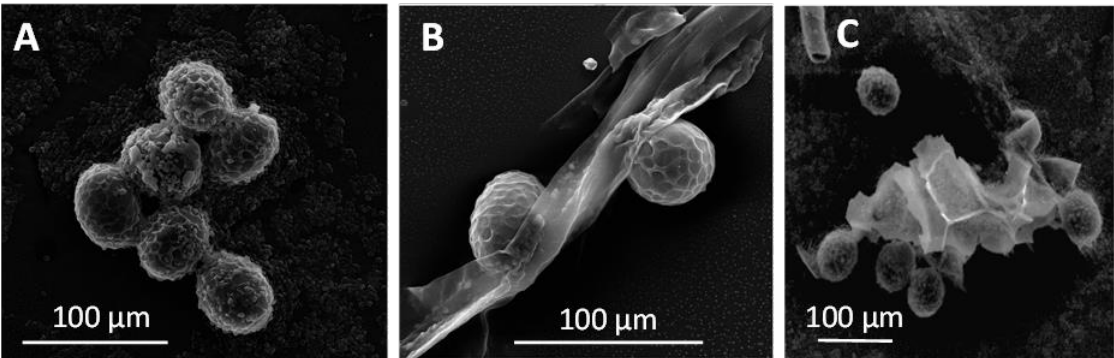
Figure 6. Scanning electron microscope images of A. suum eggs in tap and wastewater: eggs in clean tap water ( A ); the formation of floccules with suspended particles in wastewater ( B , C ).